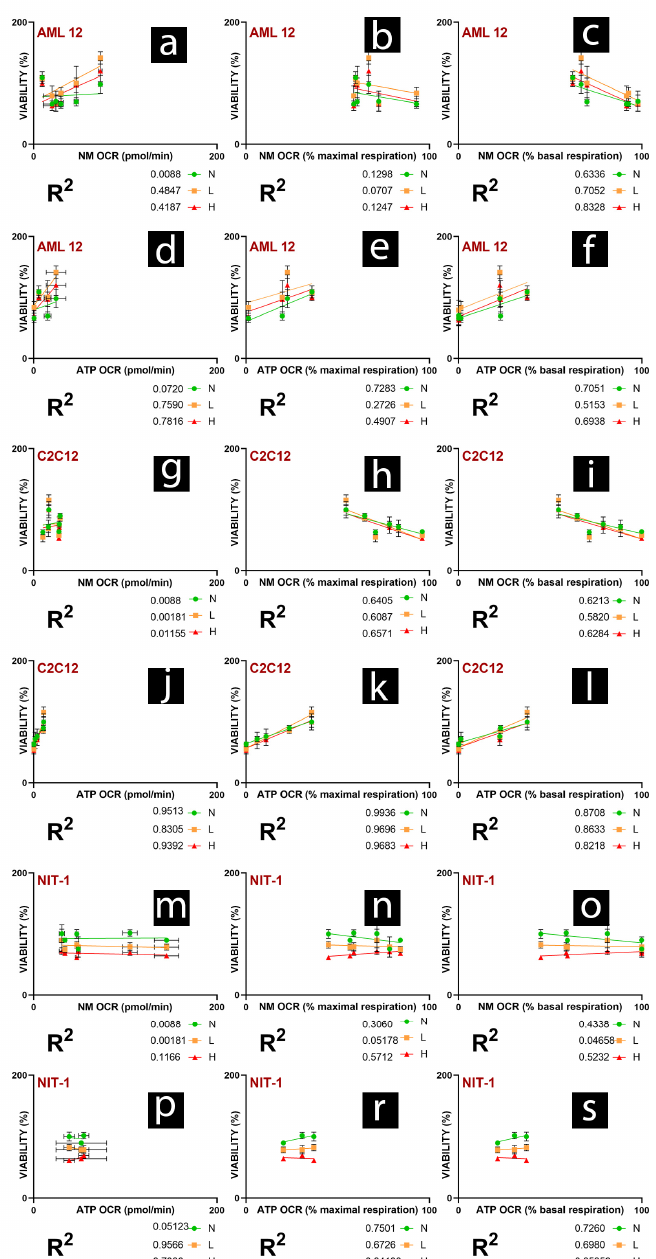
Figure 7. Relationships between bioenergetics in normoxic conditions and viability under normal, low, and high hypoxia. NM OCR, non-mitochondrial-linked OCR; ATP OCR, ATP-production-linked OCR. % maximal respiration—parameter is expressed as a % of maximal respiration, where value of maximal respiration linked OCR is 100%. % basal respiration—parameter is expressed as a % of basal respiration, where value of basal respiration linked OCR is 100%. Figure 7. shows the linear relationship of AML 12 cell viability and ( a ) NM OCR, ( b ) NM OCR as % of maximal respiration, ( c ) NM OCR as % of basal respiration, ( d ) ATP OCR, ( e ) ATP OCR as % of maximal respiration, ( f ) ATP OCR as % basal respiration. Figure 7. shows the linear relationship of C2C12 cell viability and ( g ) NM OCR, ( h ) NM OCR as % of maximal respiration, ( i ) NM OCR as % of basal respiration, ( j ) ATP OCR, ( k ) ATP OCR as % of maximal respiration, ( l ) ATP OCR as % basal respiration. Figure 7. shows the linear relationship of NIT-1 cell viability and ( m ) NM OCR, ( n ) NM OCR as % of maximal respiration, ( o ) NM OCR as % of basal respiration, ( p ) ATP OCR, ( r ) ATP OCR as % of maximal respiration, ( s ) ATP OCR as % basal